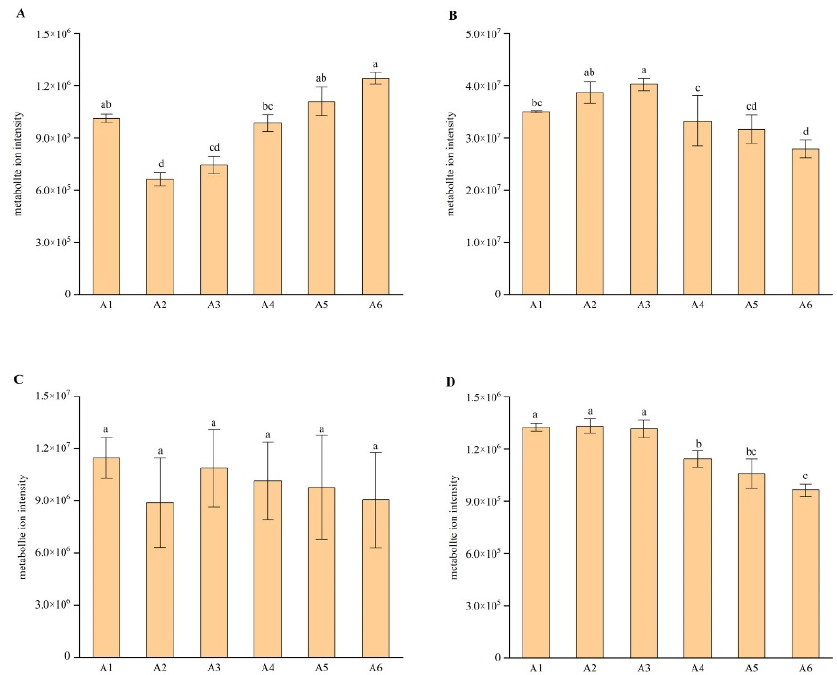
Figure 9. Integral correction results of quantitative analysis of four flavonoid compounds in different samples. The plots represent: ( A ) the difference in relative content of hesperidin in PCR at different harvest times; ( B ) the difference in relative content of nobiletin in PCR at different harvest times; ( C ) the difference in relative content of tangerine in PCR at different harvest times; ( D ) the relative contents of 3,3 (cid:48) ,4 (cid:48) ,5,6,7,8-heptamethoxyflavone in PCR at different harvest times. Different